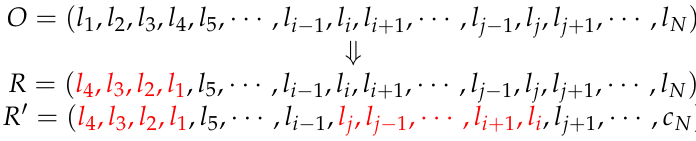
Figure 3. Inversion operator operation